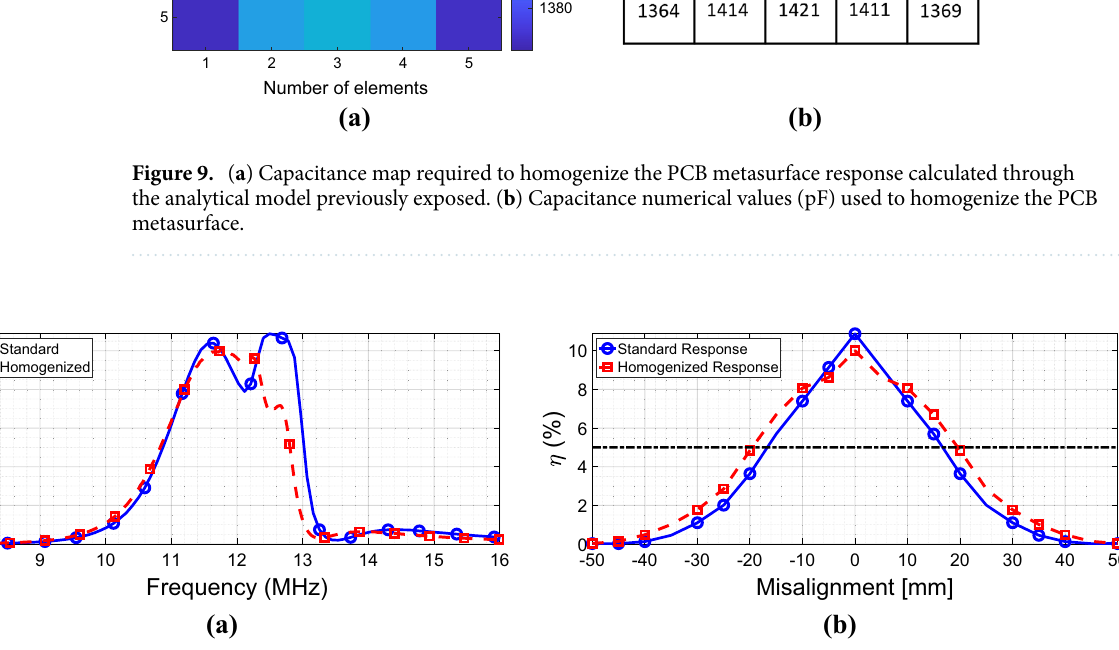
Figure 10. ( a ) Measured efficiency comparison between standard metasurface (blue full line) and homogenized metasurface (red dashed line). ( b ) Measured efficiency versus misalignment: the homogenized metasurface can outperform in terms of misalignment robustness the standard